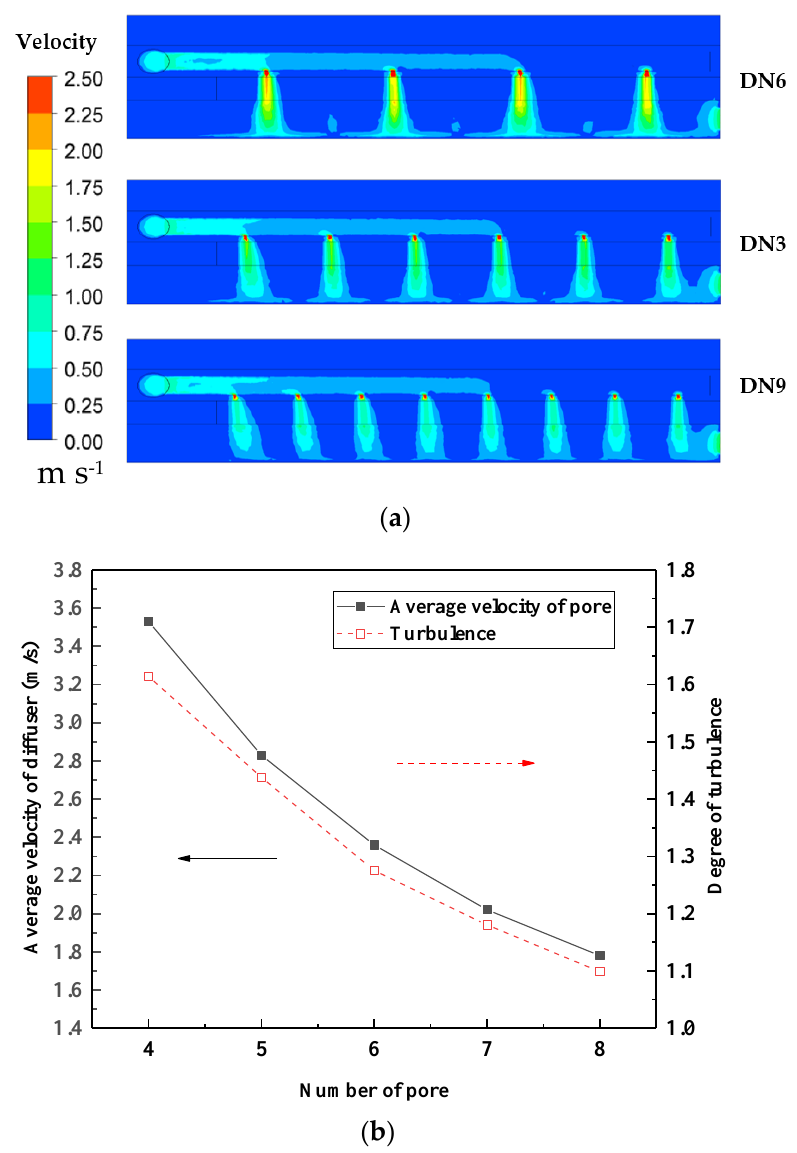
Figure 5. ( a ) Distribution of the velocity at the middle x–y plane of the branch pipe and ( b ) the average velocity and degree of the turbulence for the water diffuser under different numbers of perforated pores.